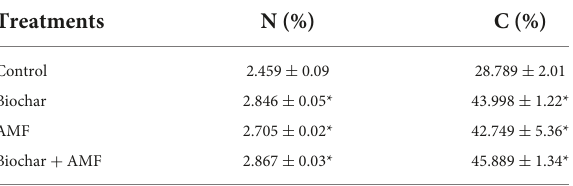
TABLE 3 The nitrogen and carbon content of leaf in soybean as affected by biochar and AMF under drought condition. Treatments